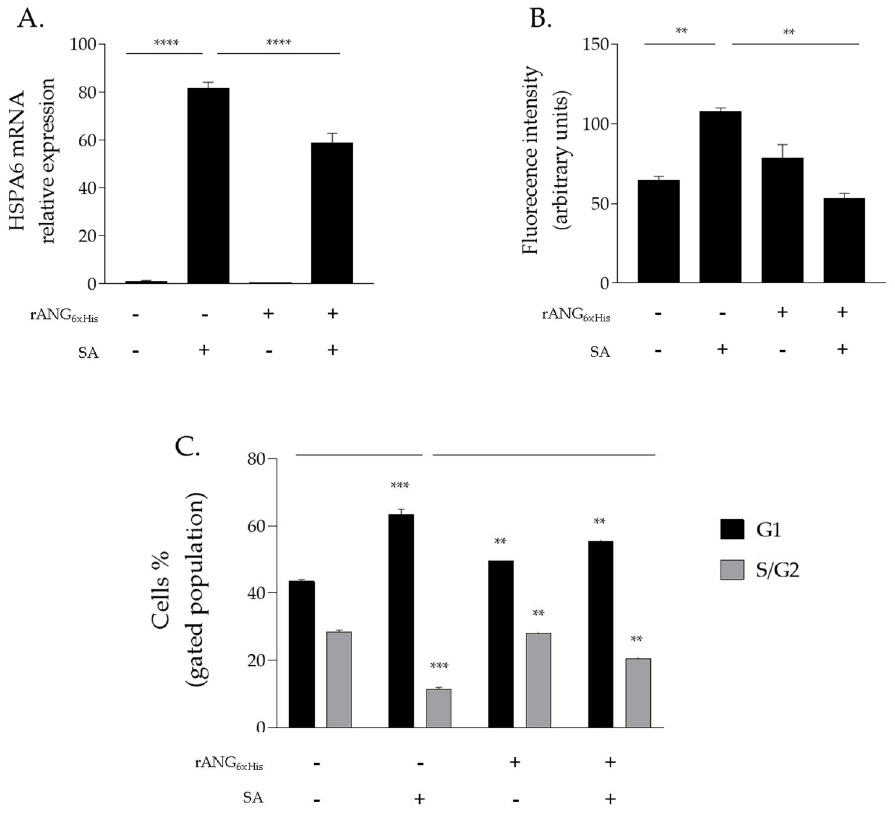
Figure 11 . rANG 6xHis effects on HaCaT cells stress response. ( A ) RT-qPCR analysis of the expression of HSPA6 gene; ( B ) intracellular ROS detection by DCFH-Da assay; ( C ) distribution of HaCaT cells population among cell cycle G1 phase and S/G2 phase. (−) untreated cells; (+) pre-treatment of cells with 2 µM rANG 6xHis or 500 µM SA. Values are the means ± SEM of biological replicates (** p < 0.01, *** p < 0.001, **** p < 0.0001) compared to the respective controls (one-way ANOVA, followed by Bonferroni’s post-test).